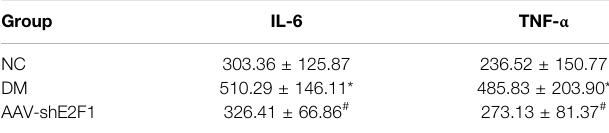
TABLE 3 | Content of IL-6 and TNF- α in renal tissue supernatant of mice in each group (n = 6,* p < 0.05 vs. NC. # p < 0.05 vs. DM). Group